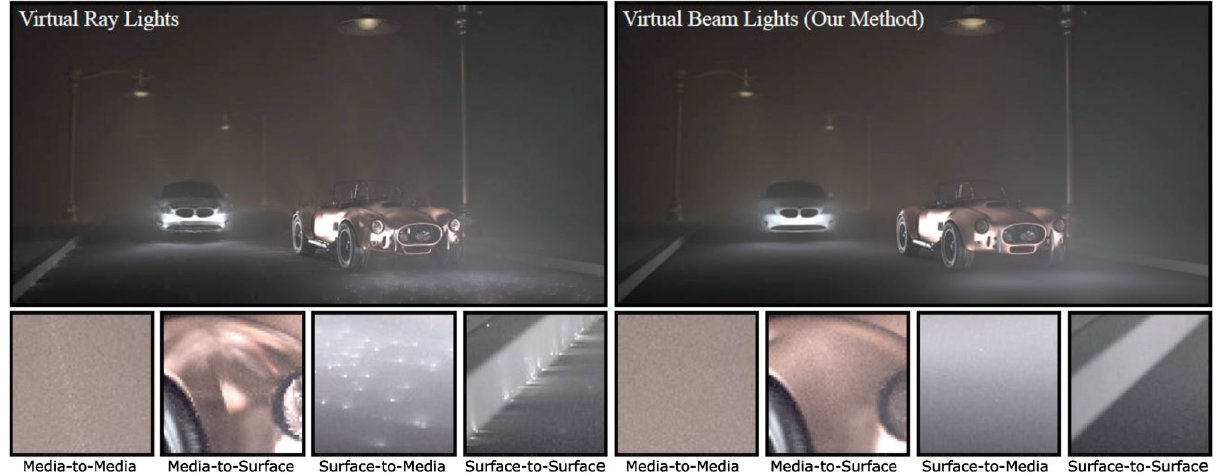
Fig. 7 Indirect illumination on surfaces and in the medium. Progressive virtual ray beams (right) significantly reduce singularity artifacts compared to the virtual ray lights method (left). Progressive rendering effectively eliminates singularities in four indirect light transport paths (below) using novel importance sampling schemes and a new compatible lighting primitive. Reproduced with permission from Ref. [14], c (cid:2) The Author(s)